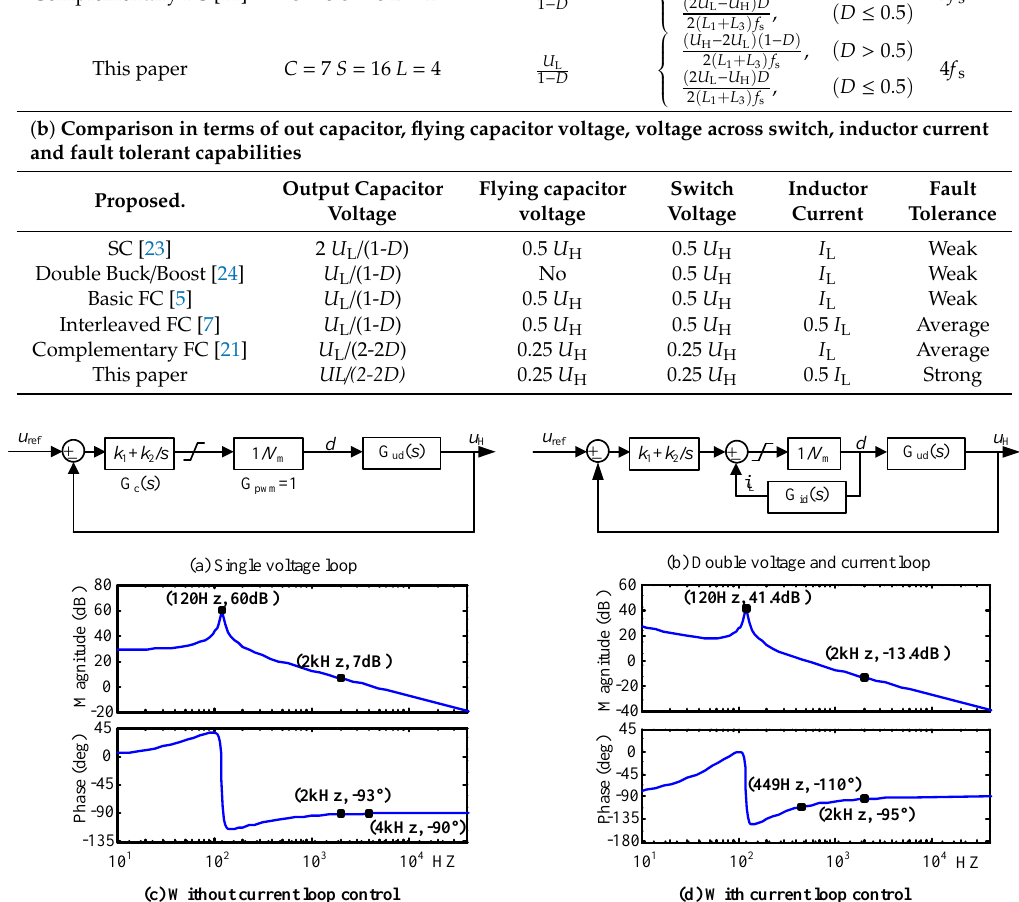
Table 5. The Parameters of BDC.